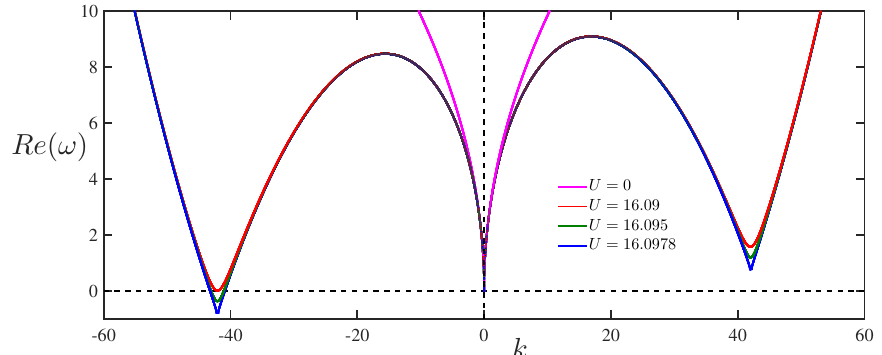
Figure 5. Non-symmetric branches of dispersion curves corresponding to waves propagating in the opposite direction. Note that the pink and blue lines have negative portions, which correspond to